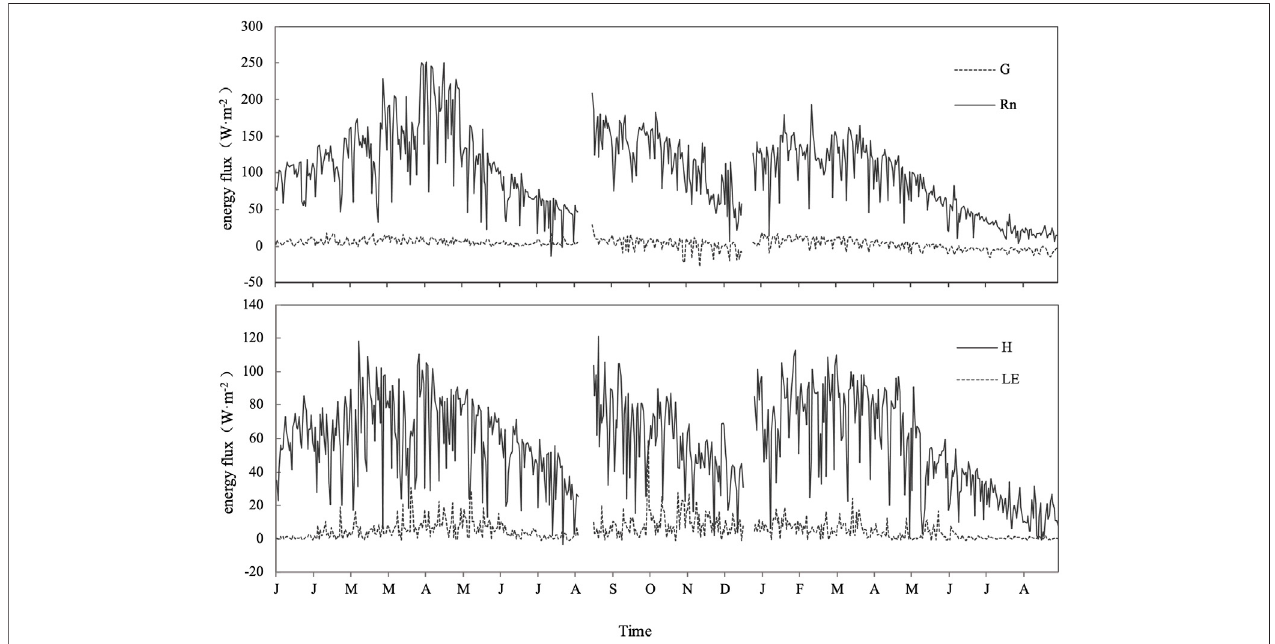
FIGURE 3 | Seasonal and interannual variation of energy fl ux of the desert ecosystem in Dengkou County, Inner Mongolia.